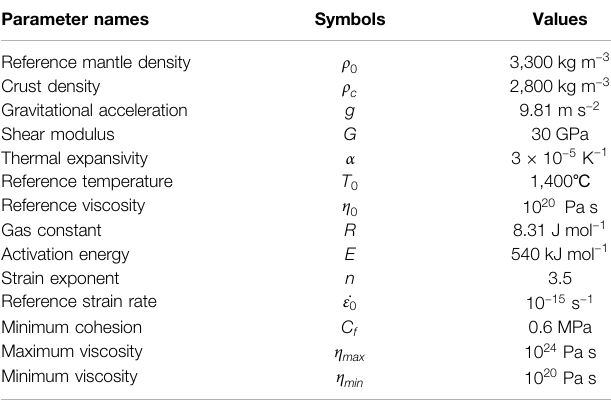
TABLE 1 | Model constants.